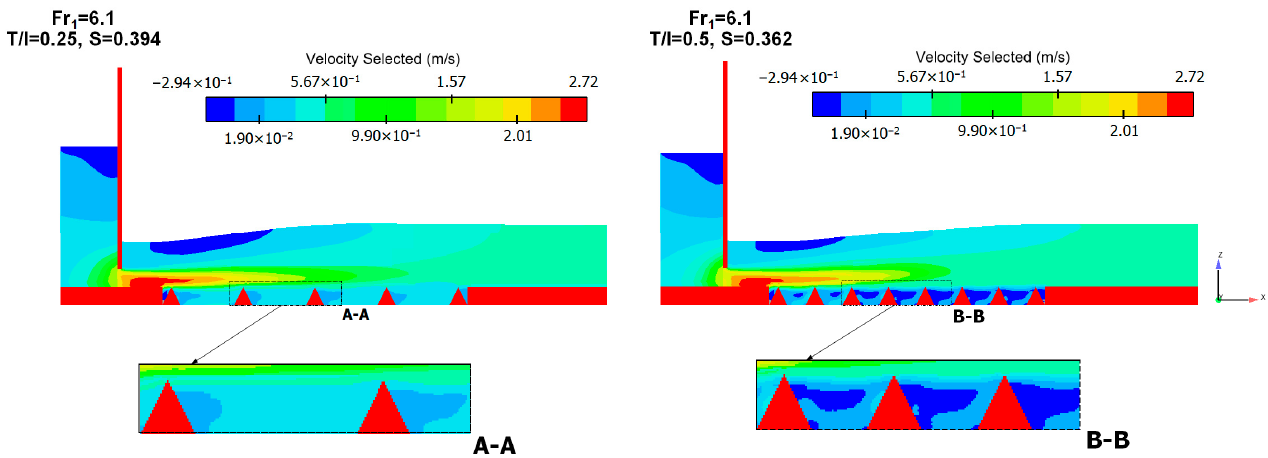
Figure 13. Stream-wise velocity distribution for the triangular macroroughnesses with T/I = 0.5 and 0.25.